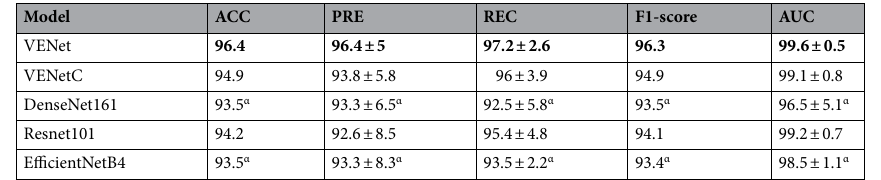
Table 3. Comparision of the VENet performance against conventional DCNN for CVD classification task (mean ± S.D.). α p < 0.05. Two-sided McNemar’s test against the proposed VENet strategy. Bold values indicate best performance.